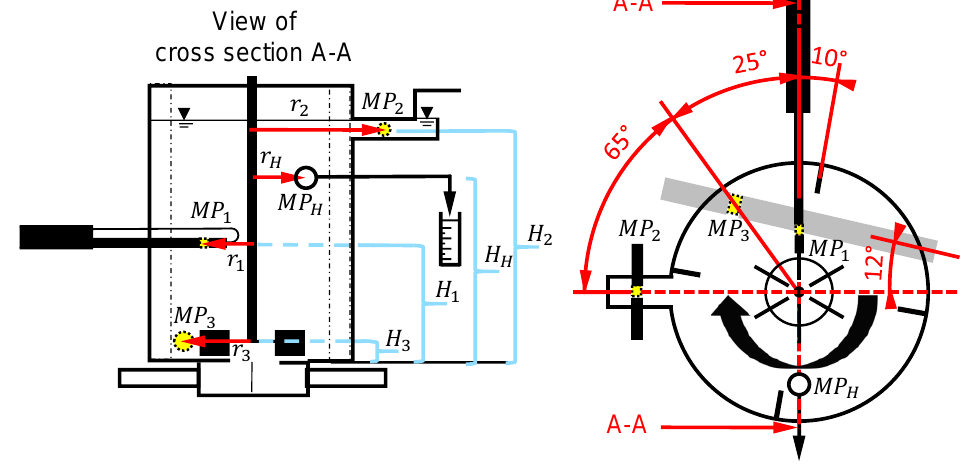
Figure 3. Measurement positions MP 1 − 3 in the DN300 General Mills pump-mixer. An endoscopic optical probe is inserted from outside at MP 1 and was also used in previous works [22,29,31,32] and is described elsewhere [33]. The positions MP 2 and MP 3 are based on a two-sided design by Mickler and Bart [30] needing a measurement flange. The measurement position MP 2 is a symmetric DN50 measurement flange with a Ø22 mm optical probe. Hence, the overflow weir is necessary to ensure the outlet tube is filled with liquid. Position MP 3 is an eccentric measurement flange with a Ø38 mm optical probe. The probe in MP 3 can be rotated at an angle of 12 ◦ (see Figure 3, left) for a better alignment with the assumed flow direction generated by the Rushton turbine. All measurement positions are equipped with a Basler acA 1300–60 gm camera and a 1 × telecentric lens, providing an image size of 1024 × 1024 pixels (5.4 mm × 5.4 mm). All measurement positions were adjusted at a depth of the measurement gap of 2 mm between the camera and LED light source of the probe. Additionally, the local holdup was measured at MP